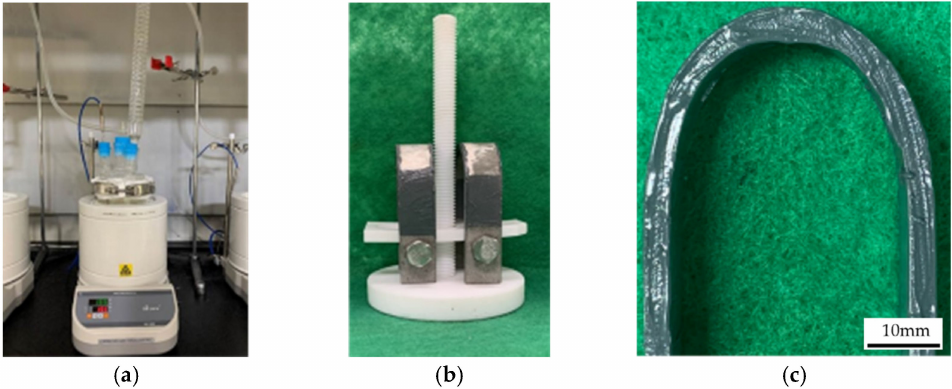
Figure 1. ( a ) Corrosion Cell for U-Bend SCC Test; ( b ) Setup of U-Bend Specimen; ( c ) Insulation on the Sides of U-Bend